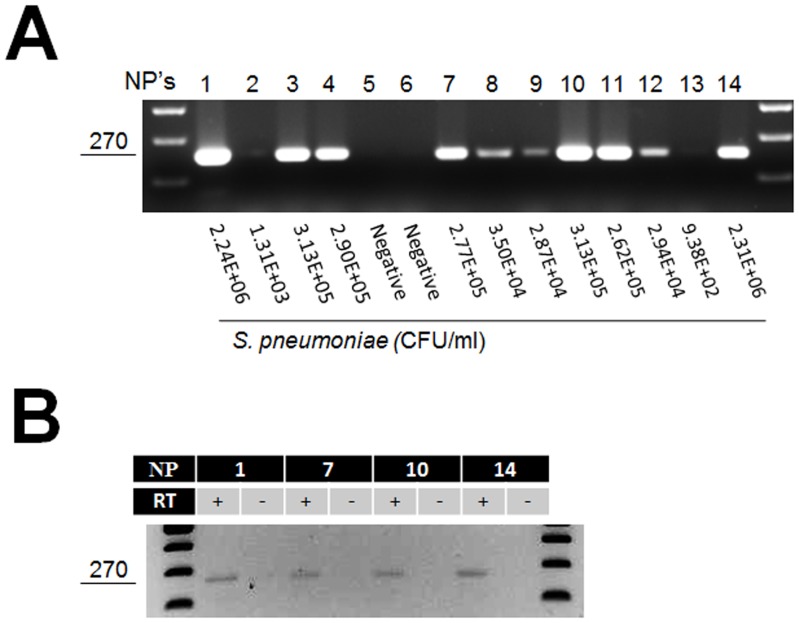
PCR amplification of the lytA gene and RT-PCR detection of its transcript.(A) DNA was extracted from NP samples and utilized as template in PCR reactions amplifying the lytA gene. The loads of pneumococcus cells in each NP sample is indicated below each lane. The larger the bacterial loads, greater the amount of DNA that should be obtained from each sample. This PCR reaction thus detected DNA from NP samples containing at least ∼2.8×104 CFU/ml (samples 8, 9 and 12). (B) RNA was extracted from the indicated NP sample and was utilized as template in RT-PCR reactions targeting the lytA gene. Reactions were added (+) or not (−) with retrotranscriptase (RT). In both panels, the size of the lytA product is shown at left in base pairs.